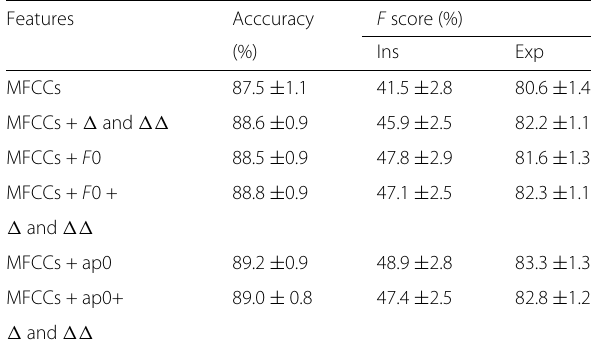
Table 4 The performance of the model with additional features Features